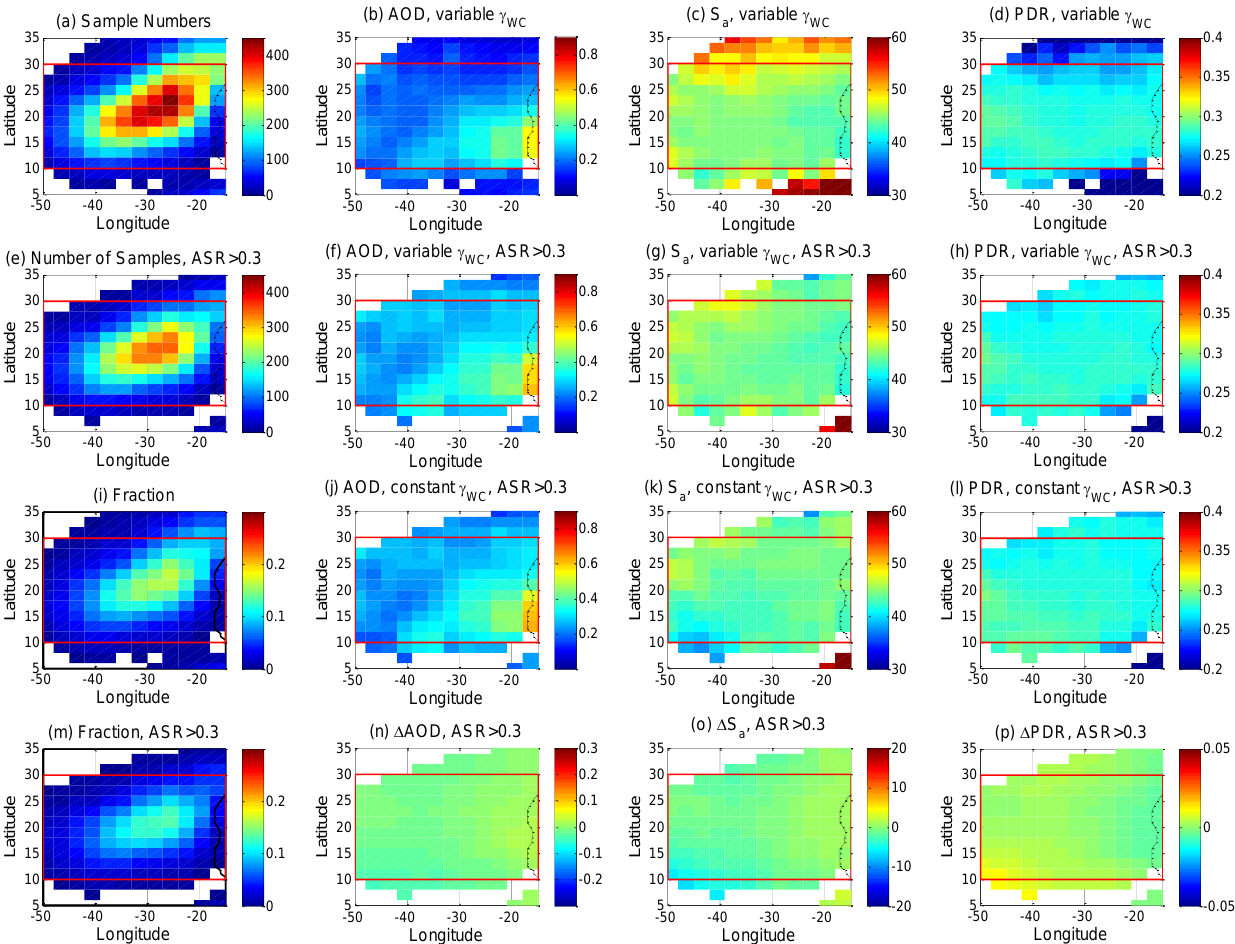
Figure 6. Analysis results in the dust region over the eastern North Atlantic from CALIOP data acquired during June–August in the years 2007–2012. (a) Number of samples, (b) AOD retrieved using the OWC technique with a location-dependent γ WC for aerosol layers located above the opaque water clouds, and (c) S a and (d) particulate depolarization ratio (PDR) retrieved using the OWC-retrieved AOD in (b) as a constraint. Shown in the second row of panels (e–h) are corresponding maps with data screening of ASR>0.3 for the overlying aerosol layers (i.e., relatively weakly scattering aerosol layers are excluded). Panels (i) and (m) show the fraction of OWC retrievals relative to the total number of measurements in each grid, respectively, for all aerosol layers and moderately dense aerosol layers. The third row of panels (j–l) are corresponding maps using a constant γ (cid:48) (0.0270sr − 1 ) averaged over the spatial domain indicated by the red box. WC, SS, NA The bottom row of panels (n–p) are the difference of the corresponding quantities retrieved using a constant γ (cid:48) and a location- WC, SS, NA dependent γ (cid:48) . The size of each grid box is 2 ◦ × 3 ◦ (lat × long). The spatial variability in the intrinsic dust optical properties S a and WC, SS, NA ( k and l ) than for those that use a location-dependent γ (cid:48) PDR is seen to be larger for the retrievals that use a constant γ (cid:48) WC,SS,NA WC, SS, NA (g and h)